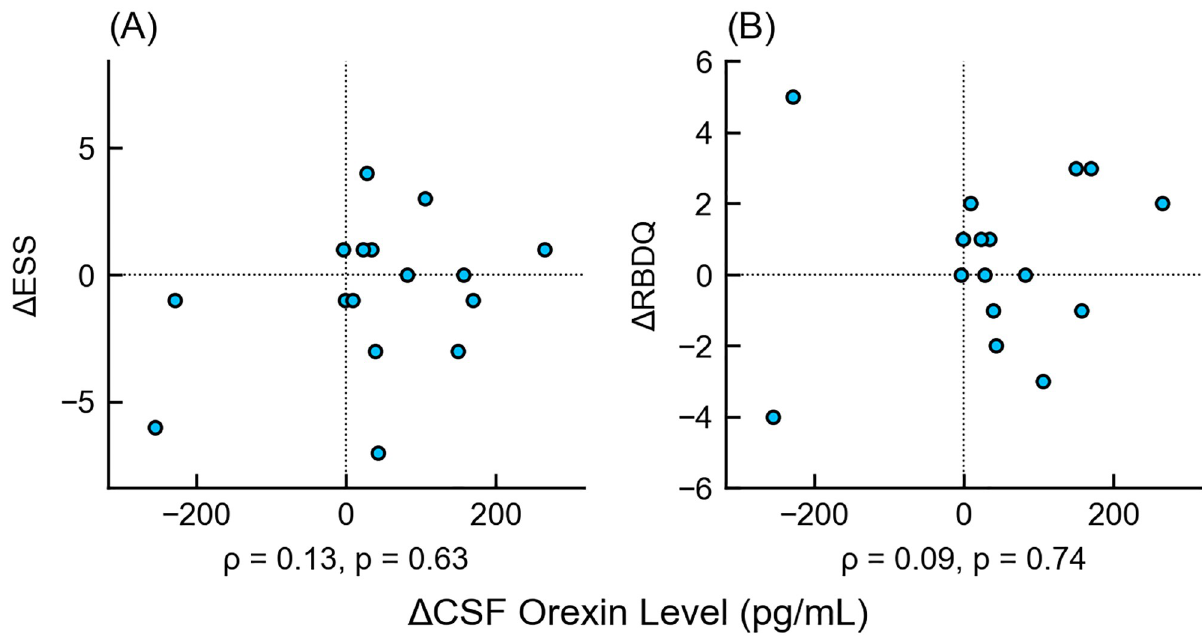
Fig 5. Scatter plot of longitudinal changes in orexin levels and main clinical characteristics. The x-axis shows the increase in CSF orexin levels since the initial examination, and the y-axis shows the increase in (A) ESS or (B) RBDQ since the initial examination. There was no correlation between the increase in CSF orexin levels and the clinical scores. Δ -, increment of -; ESS, Epworth Sleepiness Scale; RBDQ, Rapid Eye Movement Behavior Disorder Questionnaire.